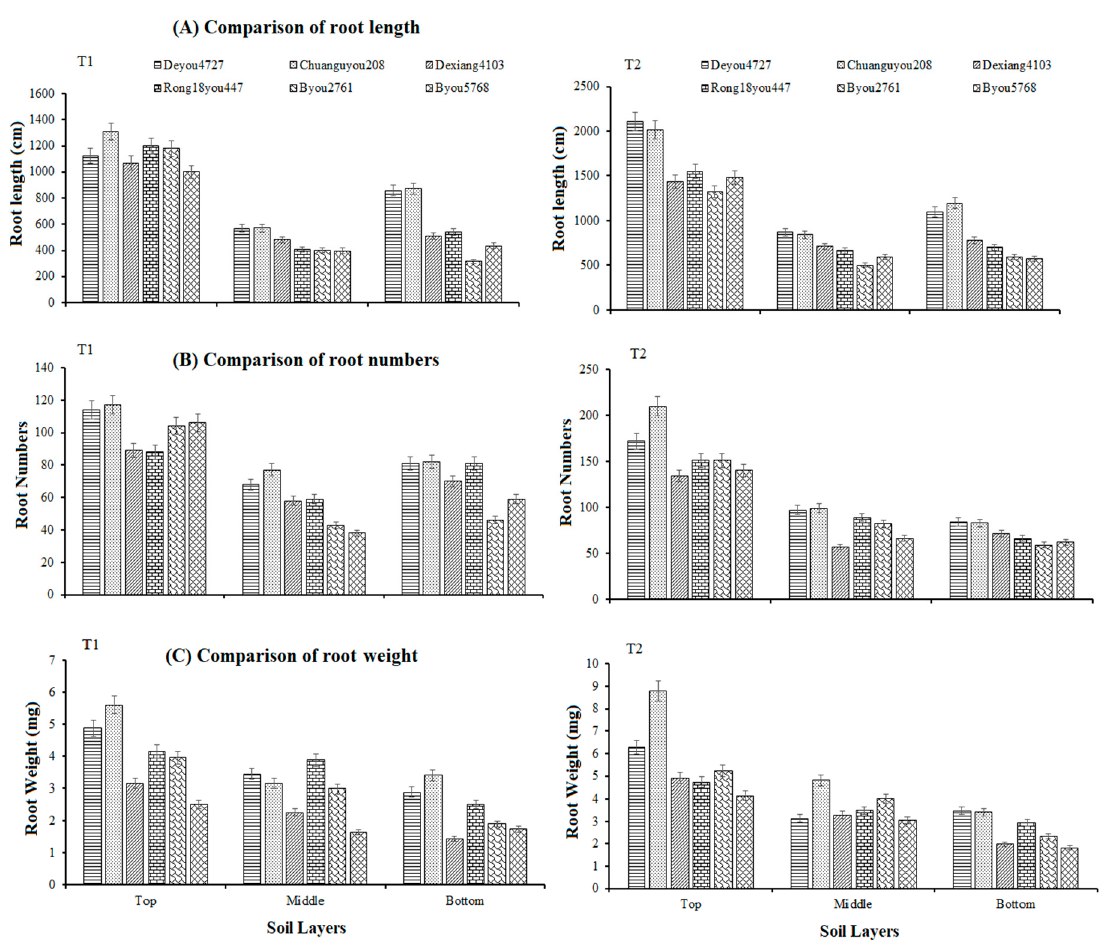
Figure 2. Comparison of Root distribution in different soil layers during two drought periods (T1 and T2). Top (0–10 cm), Middle (10–30 cm) and Bottom (30–50 cm) soil layer. ( A ) Comparison of Root length, ( B ) Comparison of Root number, ( C ) Comparison of Root weight.